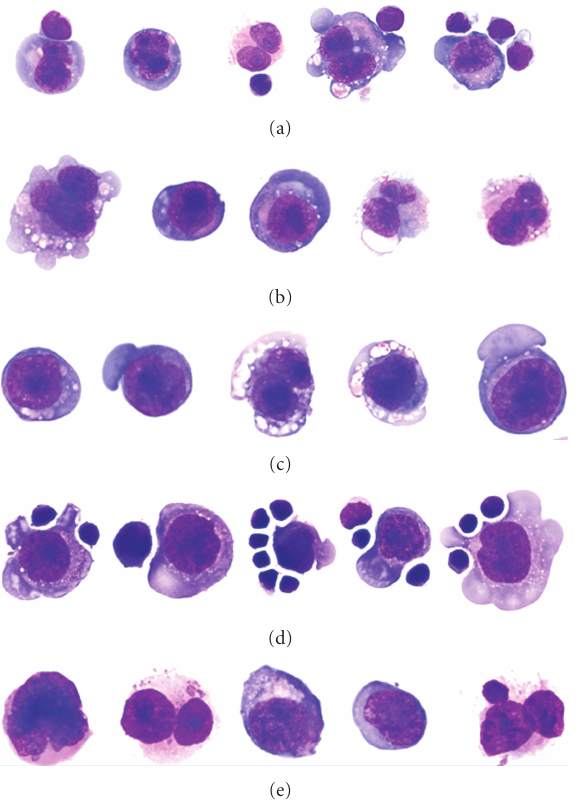
Figure 1: Wright-Giemsa-stained cytomorphology of representative, intact flow cytometric cell-sorted HRS cells from lymph nodes involved by CHL with immunophenotypes consistent with CHL. (a) A CHL case flow sorted in absence of blocking antibodies showing the presence of T cell-HRS cell rosettes. (b) The same case as seen in (a) (above) where flow sorted in the presence of blocking antibodies showing only isolated HRS cells, suggesting the blocking antibodies disrupted the rosettes. (c) A CHL case flow sorted in the presence of blocking antibodies. (d) A CHL case flow sorted in the absence of blocking antibodies showing T cell-HRS cell rosettes. (e) A CHL case flow sorted in the absence of blocking antibodies. ( c (cid:2) 2006 American Society of Clinical Pathology